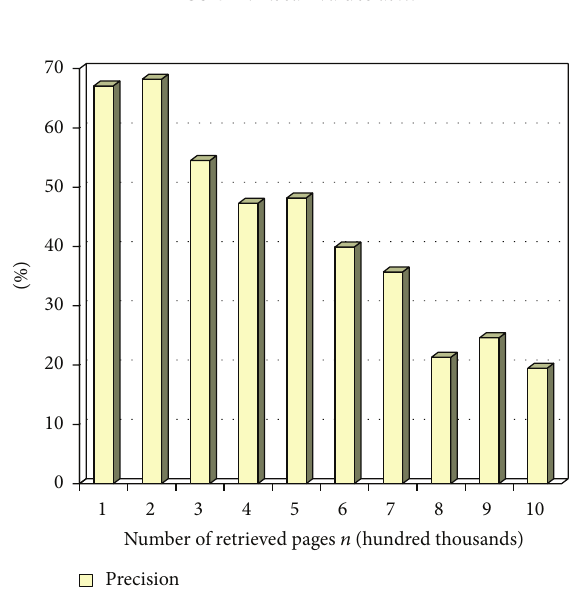
Figure 2: Recall values at 𝑛 .